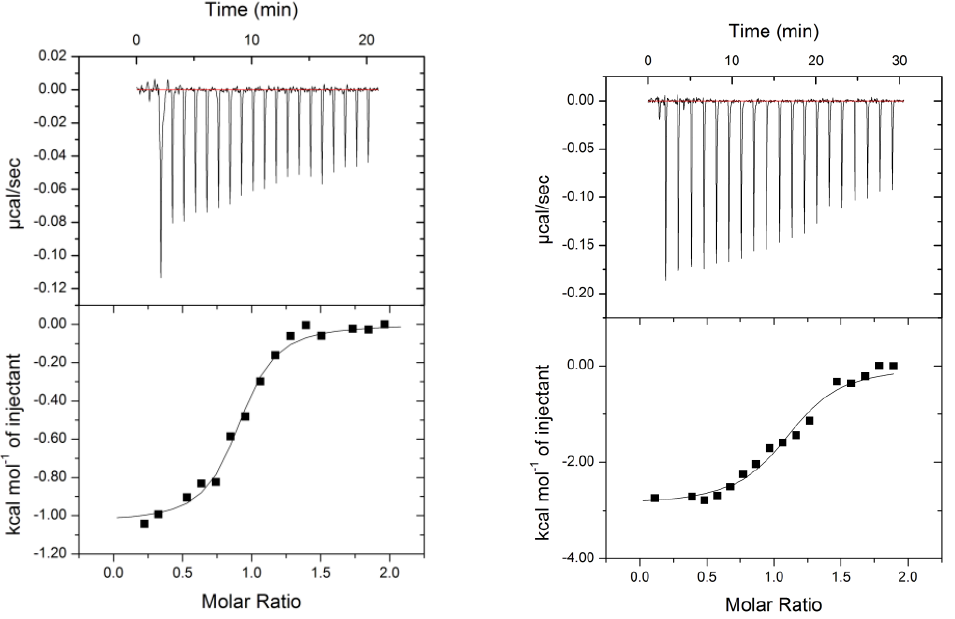
Figure 1. Interaction of compound 8 with PA-IL ( left ) and PA-IIL ( right ). Table 1. Thermodynamic parameters of interactions between lectin PA-IL and ligands.